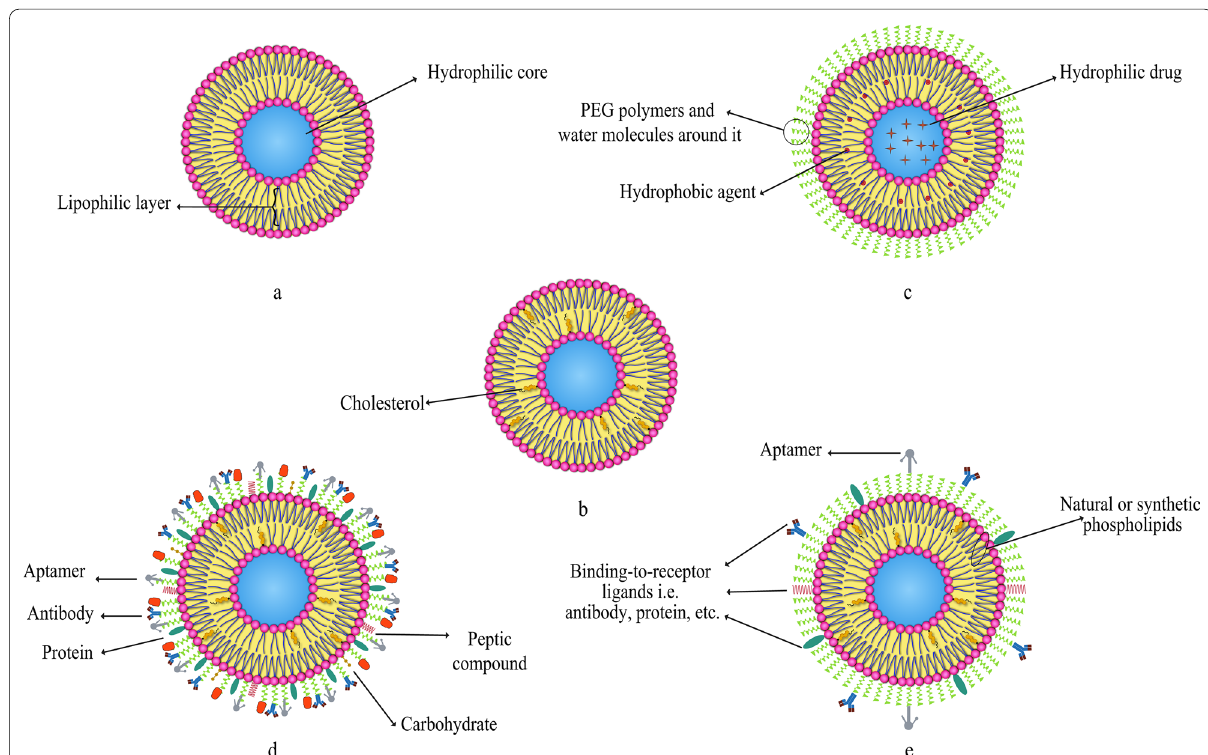
Fig. 6 Various kinds of liposomes. a Conventional liposome; b cholesterol-conjugated liposome; c PEGylated or stealth liposome; d ligand-targeted liposome; e multi-functional